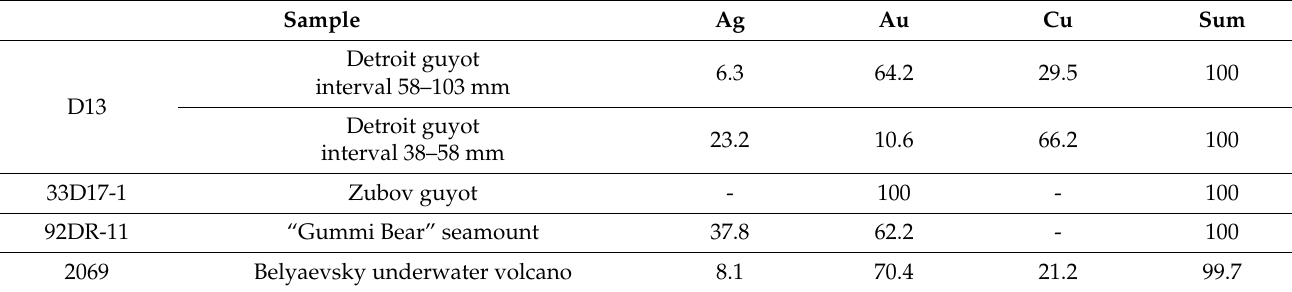
Figure 7. Microparticles of three-component native gold in the ferromanganese crust of the Belyaevsky underwater volcano [42]. Table 4. Results of microanalysis of gold micrograins in ferromanganese crusts, wt%.